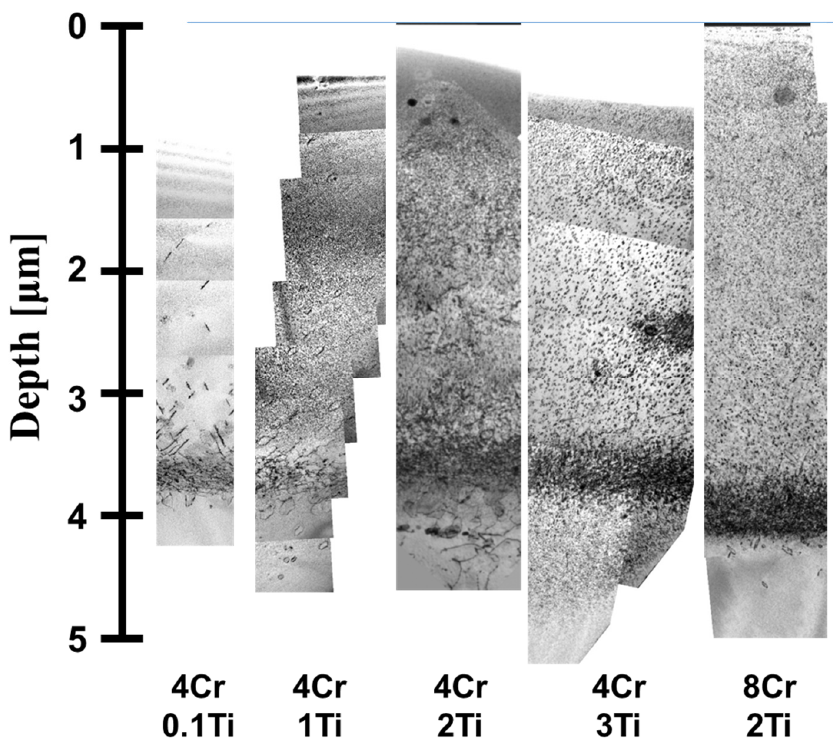
Figure 2. Cross-sectional bright-field TEM images of He-irradiated V–Cr–Ti(h) alloys at 500 °C from the irradiation surface to the peak damage area (~3.8 μ m).